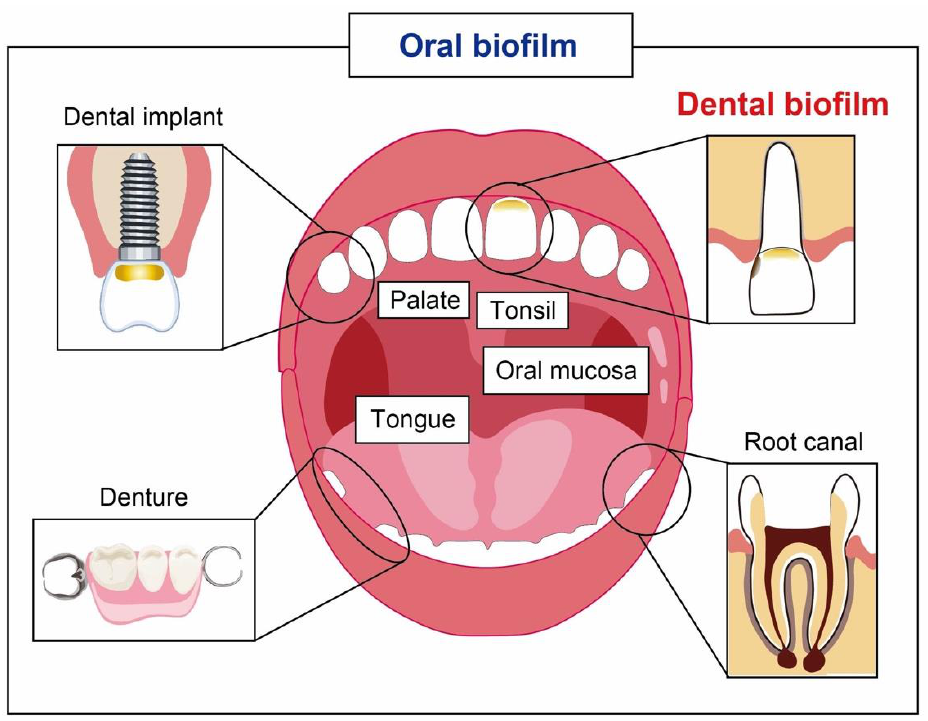
Figure 1. Oral biofilm and its niches.